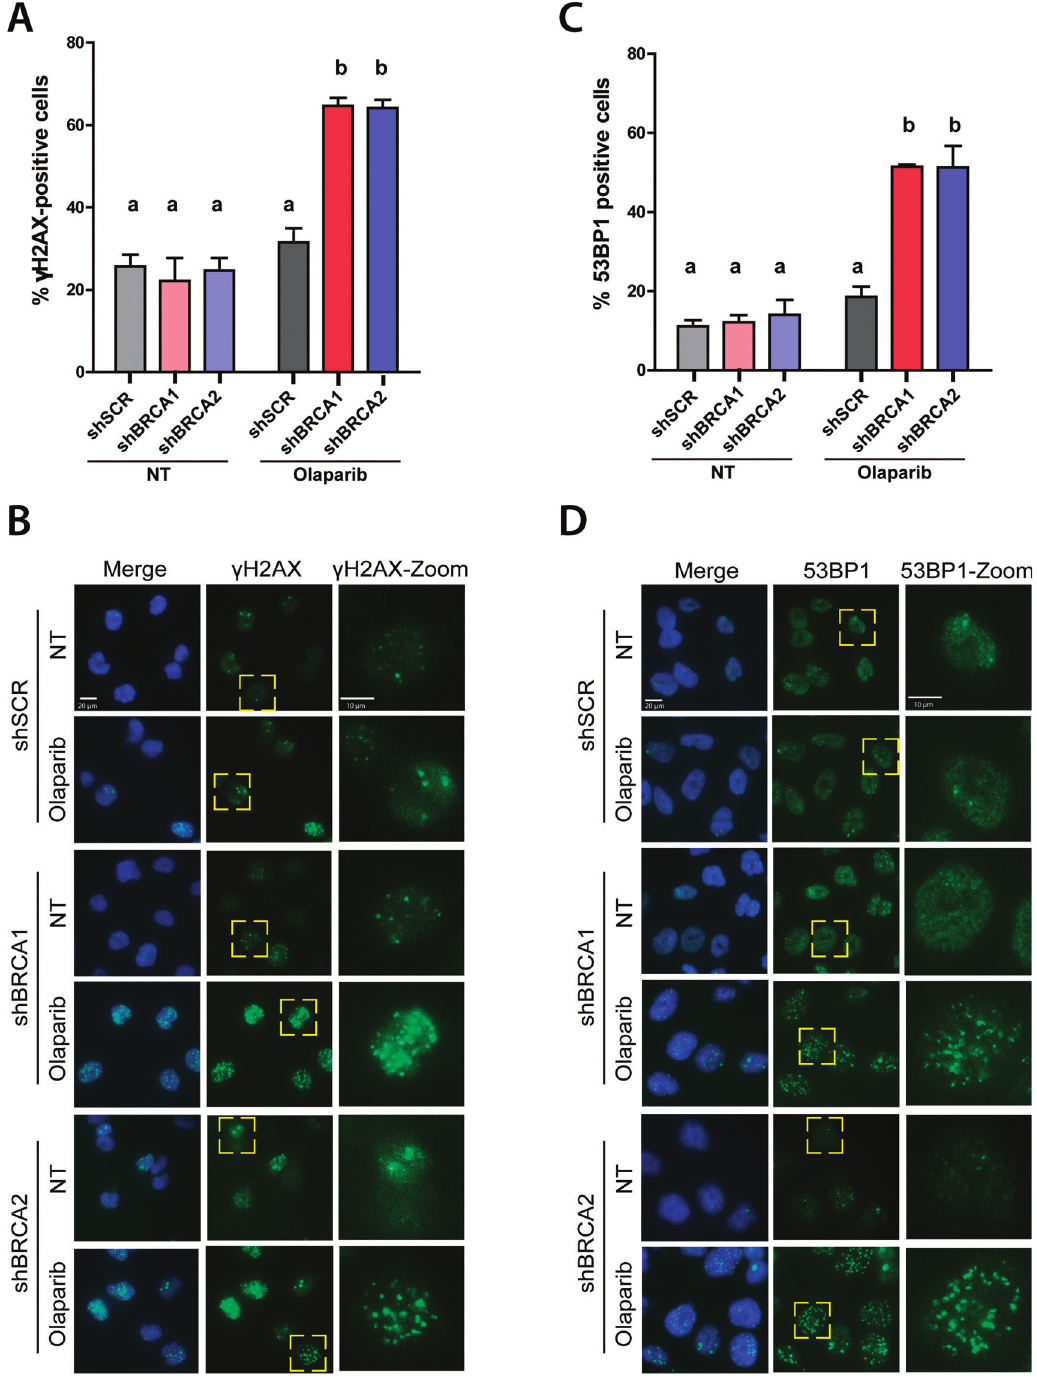
Figure 2 - The number of cells with (cid:3) H2AX and 53BP1 foci in BRCA-depleted HCT116 p21-/- cells increases after Olaparib treatment. A) HCT116 p21-/- cells transduced with shSCR, shBRCA1, and shBRCA2 cells were treated with Olaparib. After 48 h, immunostaining with (cid:3) -H2AX antibodies was per- formed. The percentage of cells with foci was quantified using fluorescence microscopy (magnification: 100X). Nuclei with more than 35 (cid:3) H2AX focal structureswereconsideredpositive.Atleast300cellsperconditionwereanalyzedin5independentexperiments.Statisticalanalysiswasperformedusing Two-wayANOVAwithBonferronipost-hoctest(*** p (cid:7) 0.001).Dataareshownasmean (cid:6) SD.B)RepresentativeimagesofdatashowedinA.Zoomim- ages of the nuclei indicated with the yellow dotted square are showed on the left. C) HCT116 p21-/- shSCR and shBRCA1 cells were treated with Olaparib. After48h,immunostainingwitha53BP1antibodywasperformed.Thepercentageofcellswithfociwasquantifiedusingfluorescencemicroscopy(mag - nification: 100X). Only nuclei with more than five 53BP1 foci were quantified as positive. At least 300 cells per condition were analyzed and data are shown as mean (cid:6) SD from5 independent experiments. D) Representative images of data showed in C. Zoom images of the nuclei indicated with the yel- lowdottedsquareareshowedontheleft.StatisticalanalysiswasperformedusingTwo-wayANOVAwithBonferronipost-hoctestanddifferenceswith p (cid:7) 0.001 were considered significant. In all graphs, the letters above the different values indicate groups that are significantly